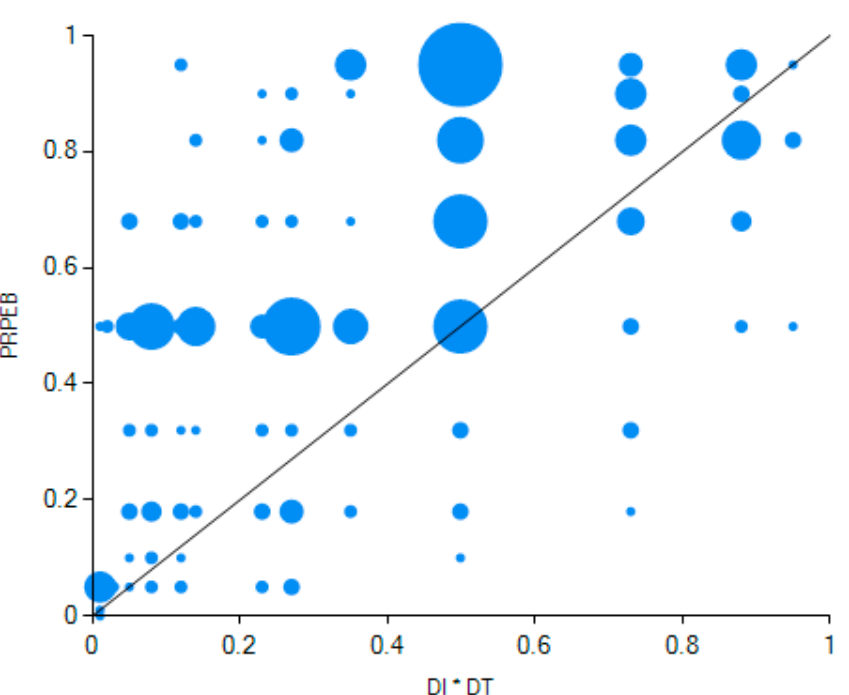
Figure 4. Explanation example of configuration 3 in the private pro-environmental behavior mode.